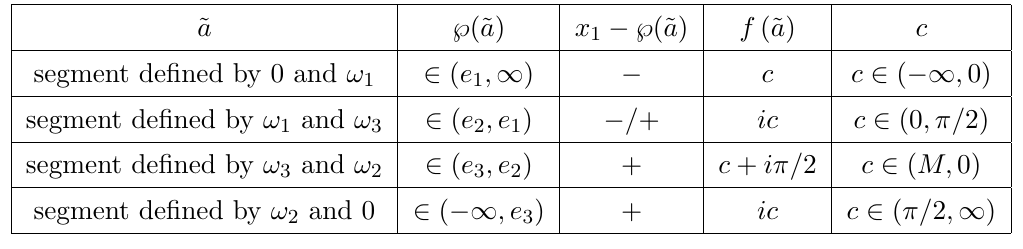
Table 1 . The values of the parameters, entering the equations (3.16) and (3.20), for various values of ~ a . In the 3rd column, 2nd row the sign (cid:0) corresponds to oscillating solutions, while the sign + corresponds to rotating